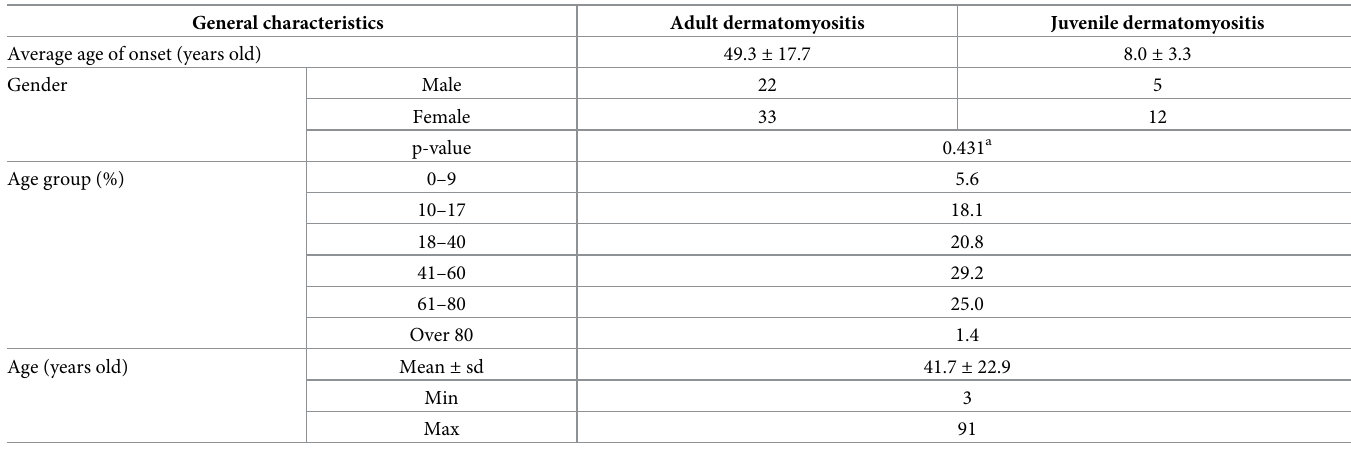
Table 1. The baseline characteristics of research subjects (n =